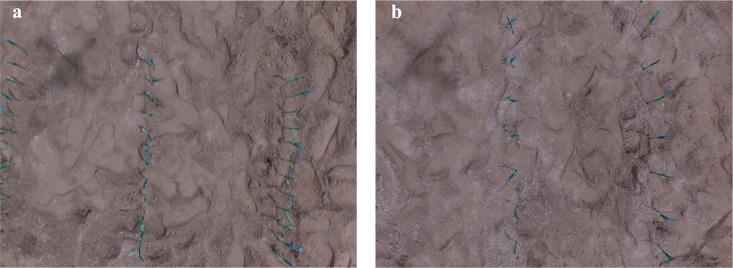
Example of images acquired by UAV platform.(a) S9cm_1m. (b) S18cm_1m.